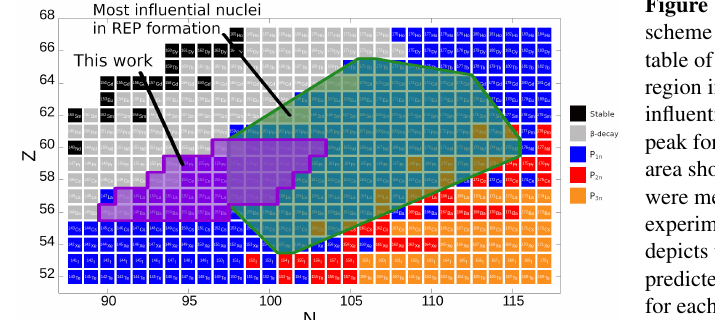
Figure 1. (Color online) This scheme shows a section of the table of isotopes. The green region indicates the most influential nuclei in rare-earth peak formation [2]. The purple area shows the isotopes that were measured in this experiment. The figure also depicts the main decay channel predicted by theoretical models for each isotope